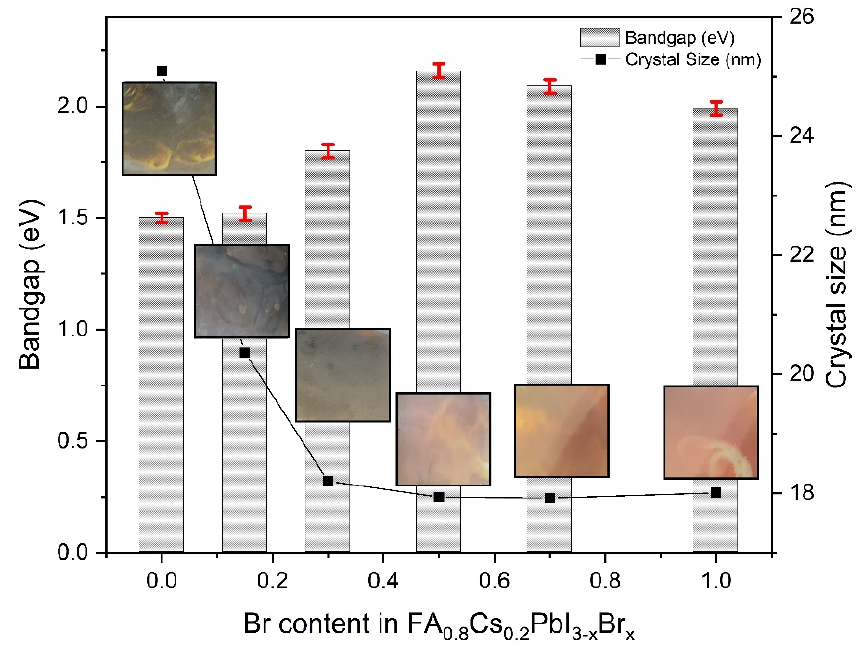
Figure 4. Relationship between the Br concentration, bandgap and crystal size of the FA 0.8 Cs 0.2 PbI 3 − x Br x perovskites. The insets show top-view photographs of the 1 × 1 cm 2 films taken after deposition and the red bars represent the error for the bandgap.